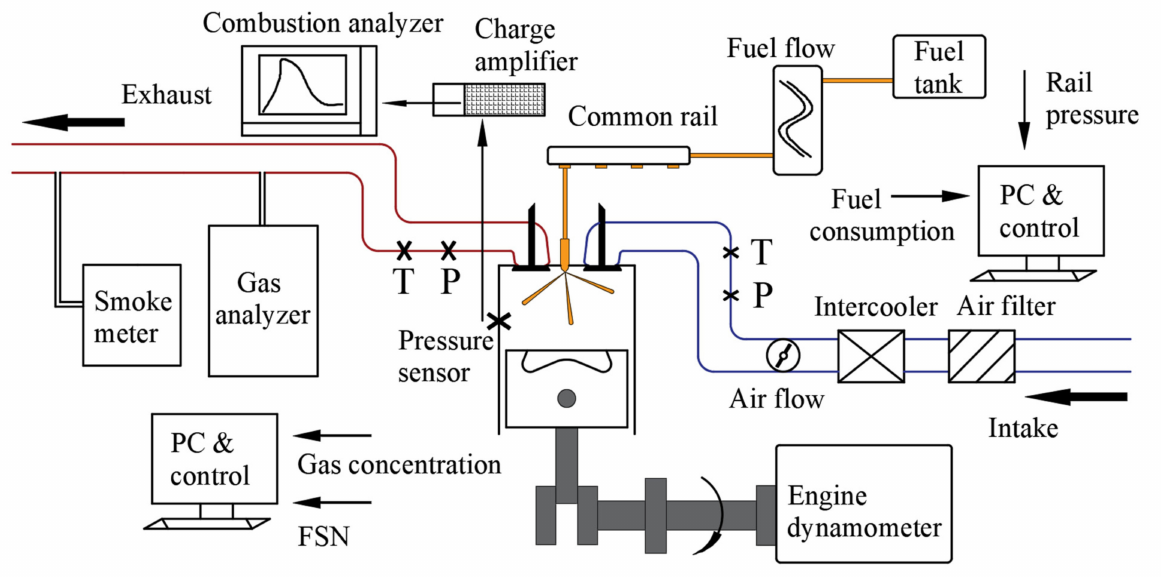
Figure 1. Schematic diagram of the engine test